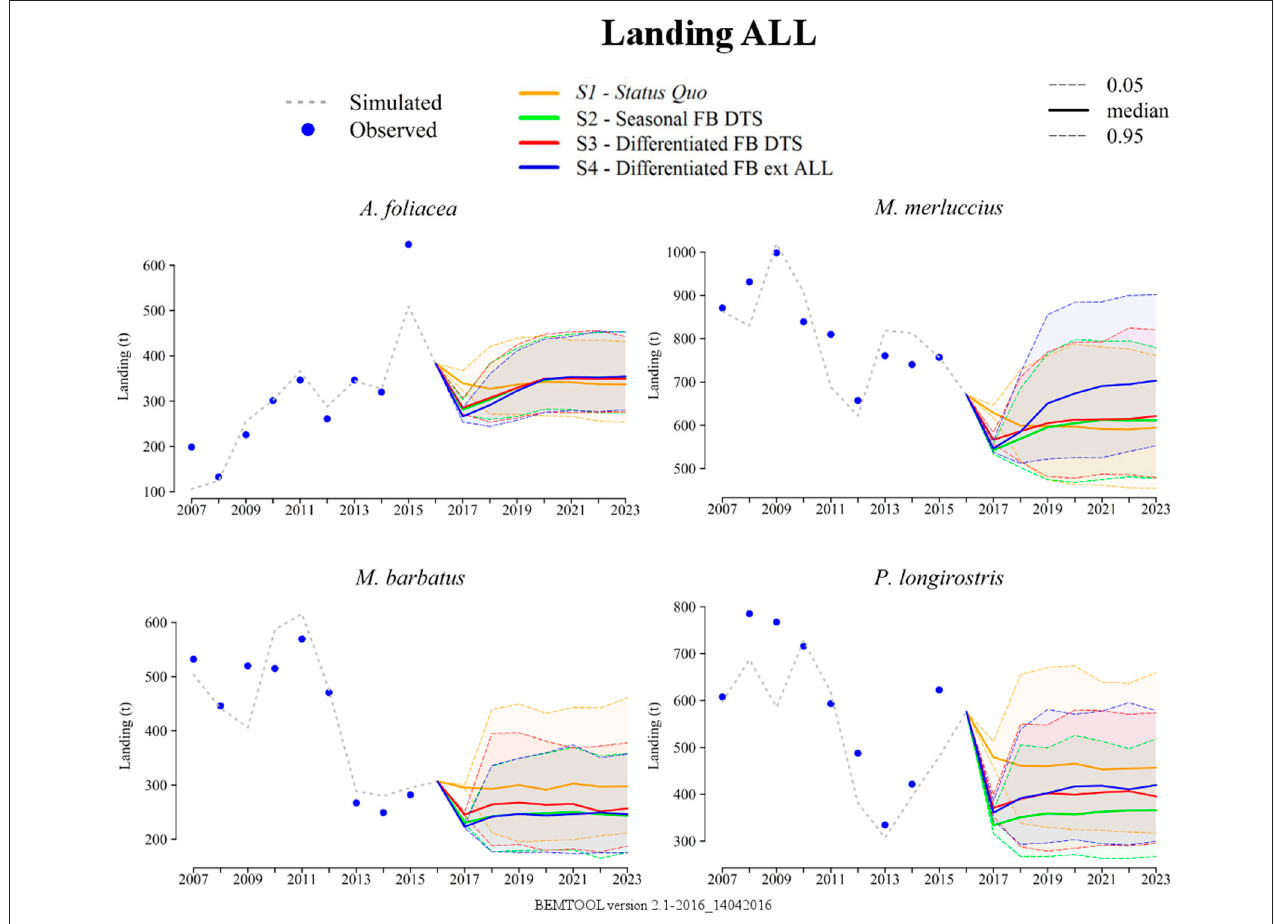
FIGURE 5 | Comparison among the scenarios of landings (all fleet segments) by target stocks in the hindcasting (2007–2016) and forecasting (2017–2023) timelines. Dotted line, Hindcasting from the bioeconomic modeling tool (BEMTOOL); Blues points, observed landing (DCF data).